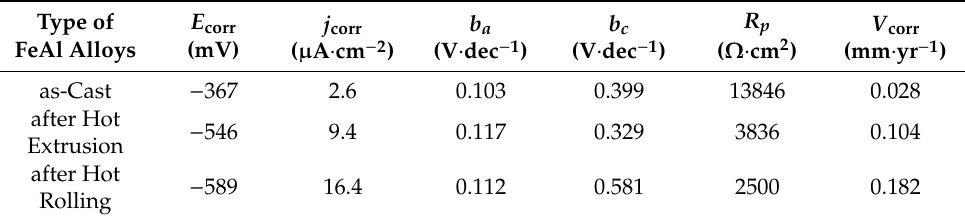
Figure 9. Dependences of E = f(t) for the FeAl alloys. Table 4. Corrosion parameters of all tested FeAl alloys.